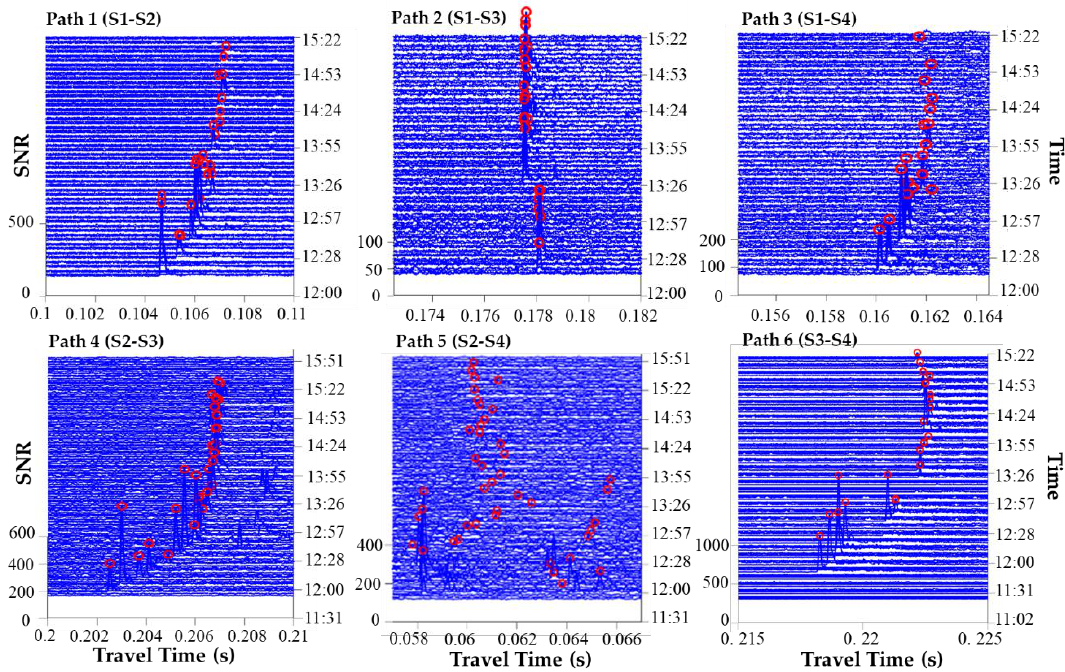
Figure 5. Stack diagram of the correlation patterns with first-arrival peaks marked with red circles.